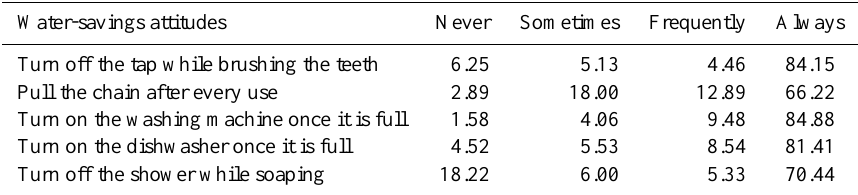
Table 3. Frequency of water-saving attitudes (in